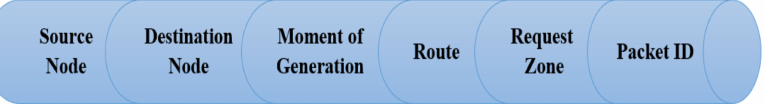
Figure 6. The contents of RREQM.